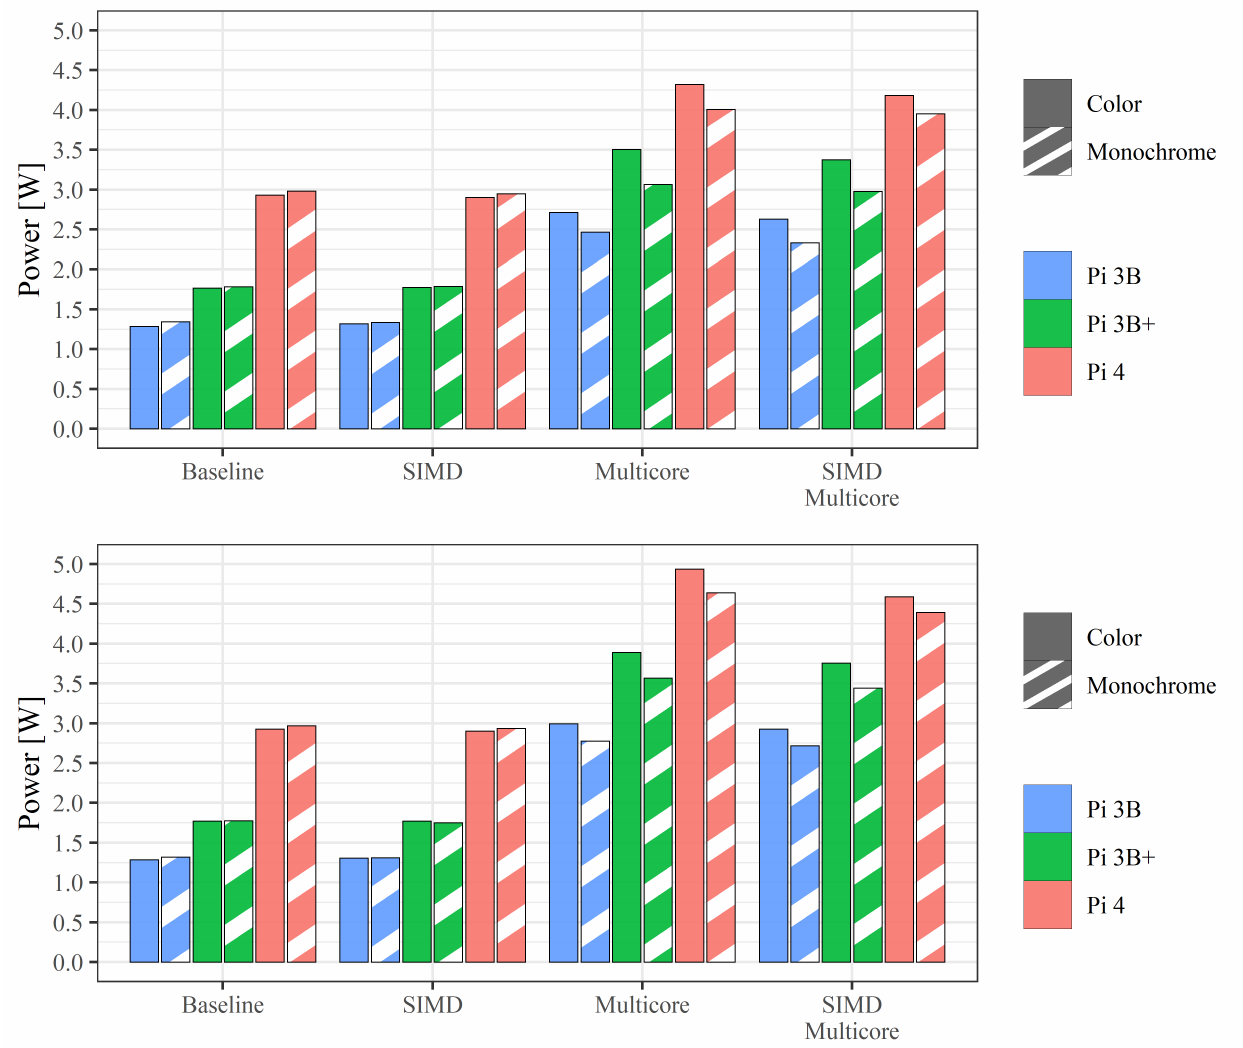
Figure 8. OTV algorithm: power consumption at ( Top ) full resolution and ( Bottom ) half